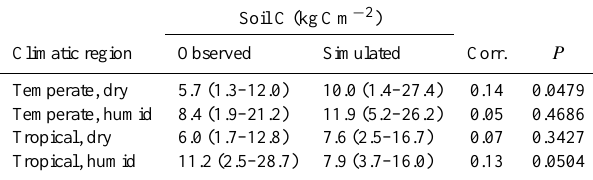
Table 3. Soil C pools (0–1.5m) in four climatic regions, observed (Batjes, 2014) and simulated, with the 0.05 and 0.95 percentiles in parenthesis. In the last two columns, the correlation coefficients and the p values are shown to demonstrate that there is a positive relationship between simulated and observed